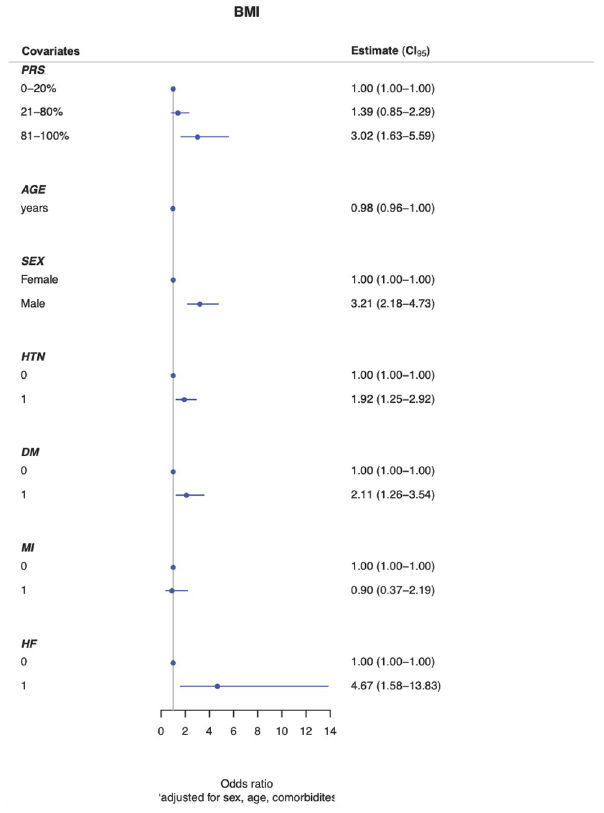
Fig 1. Adjusted polygenic risk score for BMI groups in African Americans. Abbreviations: BMI, body mass index; CI, confidence interval; HTN, hypertension; DM, diabetes mellitus; MI, myocardial infarction; HF, heart failure.